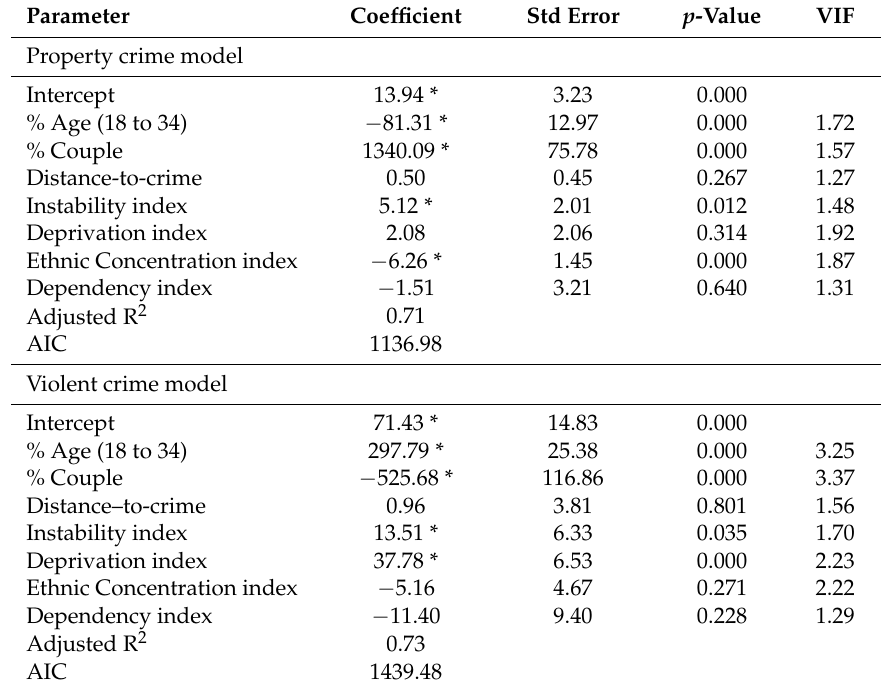
Table 4. Ordinary Least Squares (OLS) regression results for violent and property crime, respectively (n = 140).